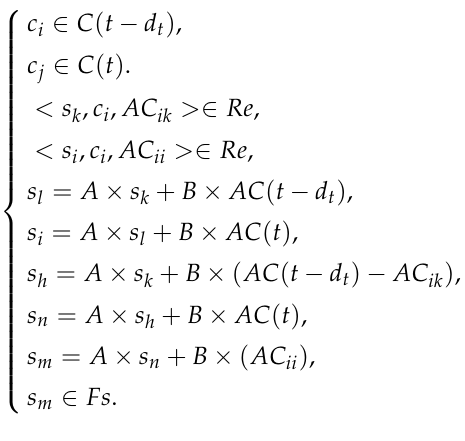
Figure 4. Attack model based on false command sequence